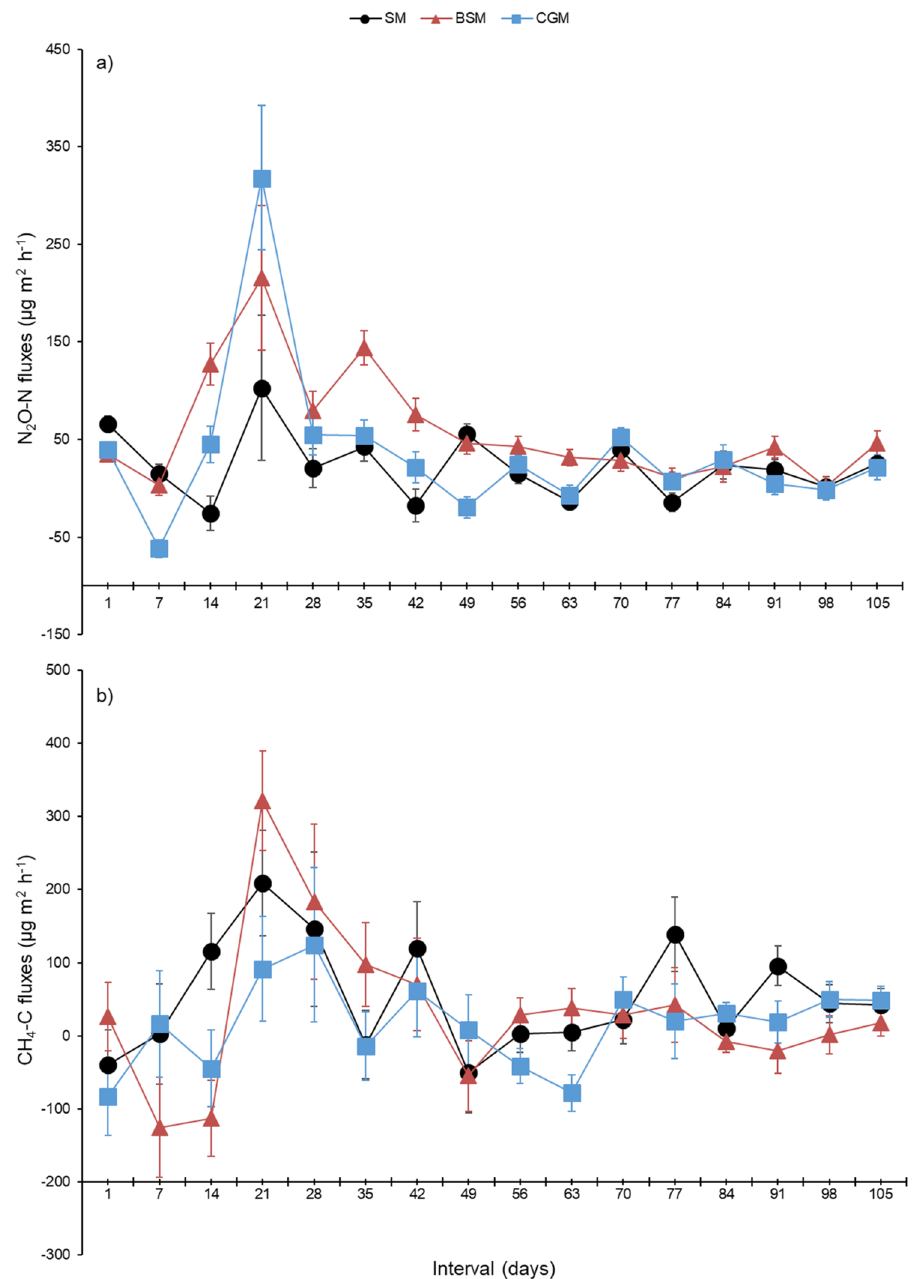
Figure 2. N 2 O and CH 4 fluxes from the manure of Nellore cattle fed with sources of rumen undegradable protein during the finishing phase in feedlots. SM = manure of animals fed soybean meal as a source of rumen degradable protein (RDP), BSM = manure of animals fed by-pass soybean meal as a source of rumen undegradable protein (RUP), CGM = manure of animals fed gluten meal as a source of RUP. P-values for N 2 O (treatment = 0.003; time < 0.001; treatment × time interaction < 0.001) and CH 4 (treatment = 0.165; time < 0.001; treatment × time interaction < 0.005). Chamber considered as an experimental unit (n = 9). The error bars representing standard error of the